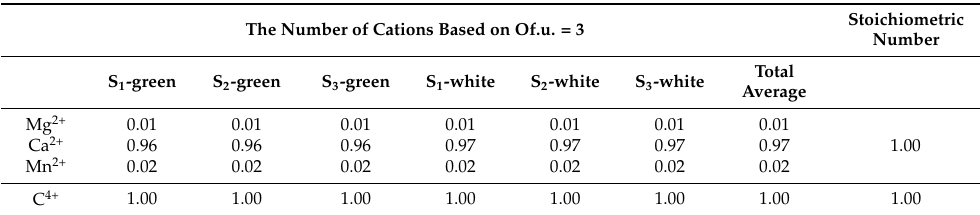
Table 3. Molar composition of three Lvwen stone specimens. The Number of Cations Based on Of.u. = 3